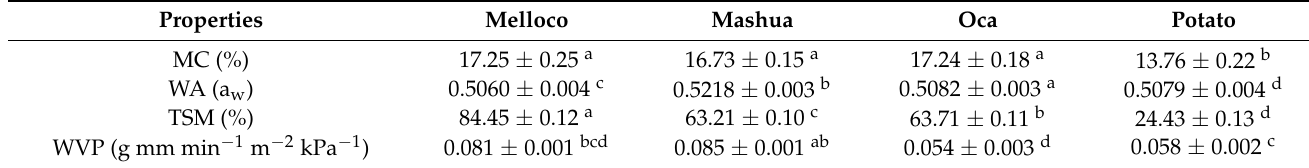
Table 2. Moisture content (MC), water activity (WA), total soluble matter (TSM), and the water vapor permeability (WVP) data comparison among the starch-based films blended from each Andean tuber studied.